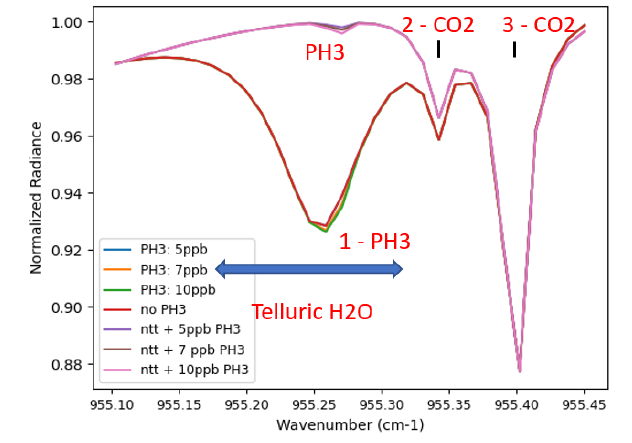
Figure 10. Exploration of the effect on the Venusian spectrum of the variation of abundance of PH 3 , between 955.15 cm − 1 (10.470 µ m) and 955.4 cm − 1 (10.467 µ m), for a resolving power of R = 80,000. The simulations were normalized by the maximum value of radiance in each simulation as a first approximation. Telluric water absorption dominates the region of the spectrum where the phosphine absorption line should be present, namely at 955.15–955.35 cm − 1 . The simulations include three different phosphine abundances—5 ppb, 7 ppb and 10 ppb—for two different situations, namely telluric absorption and removing telluric absorption (ntt). Without telluric absorption, it is much easier to identify the phosphine absorption line than it is when including telluric absorption. Absorption lines are numbered (see Table 3). The error of the simulations is approximately 0.1%.